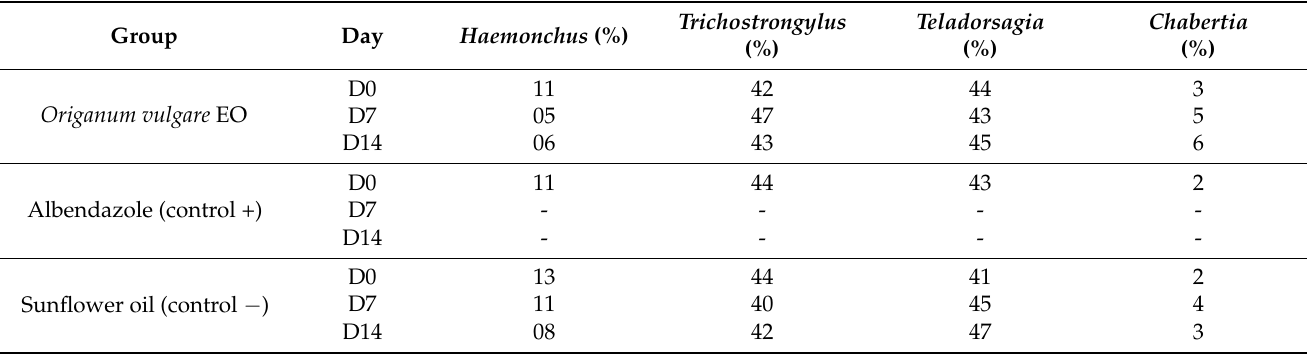
Table 6. Percentage of sheep nematode third-stage larvae (L3) for each group at D0, D7, D14, and D21 in sheep farm